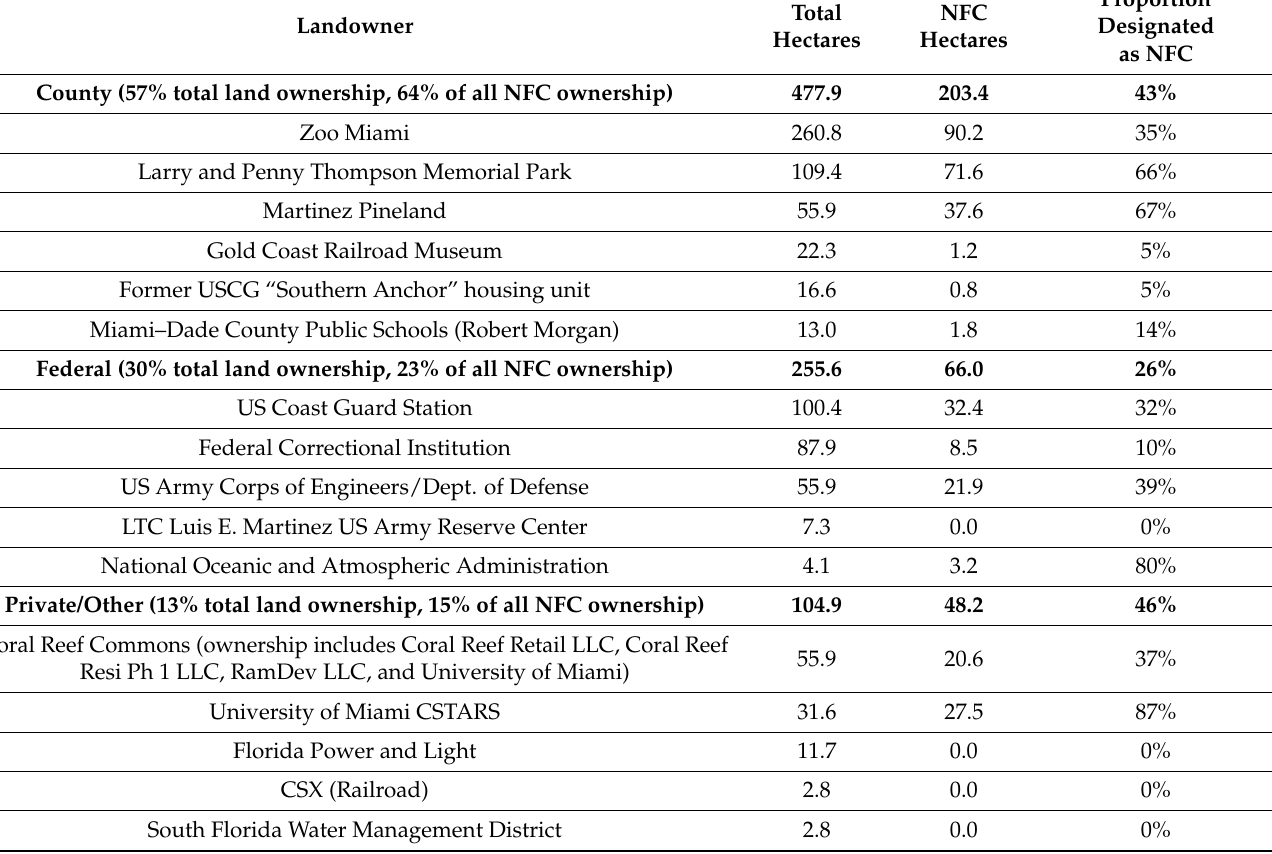
Table 1. Land ownership at the Richmond Tract (adapted from Table 1 of Possley et al. 2018). Miami– Dade County is the largest landowner at TRT with 57% of all land and 64% of all the Natural Forest Community), second is federal stakeholders with 30% total and 23% NFC ownership, and private property owners with 13% total and 15% NFC land. Meanwhile, private lands contain the highest proportion of designated NFC lands (46%) followed by Miami–Dade County (43%) and federal properties